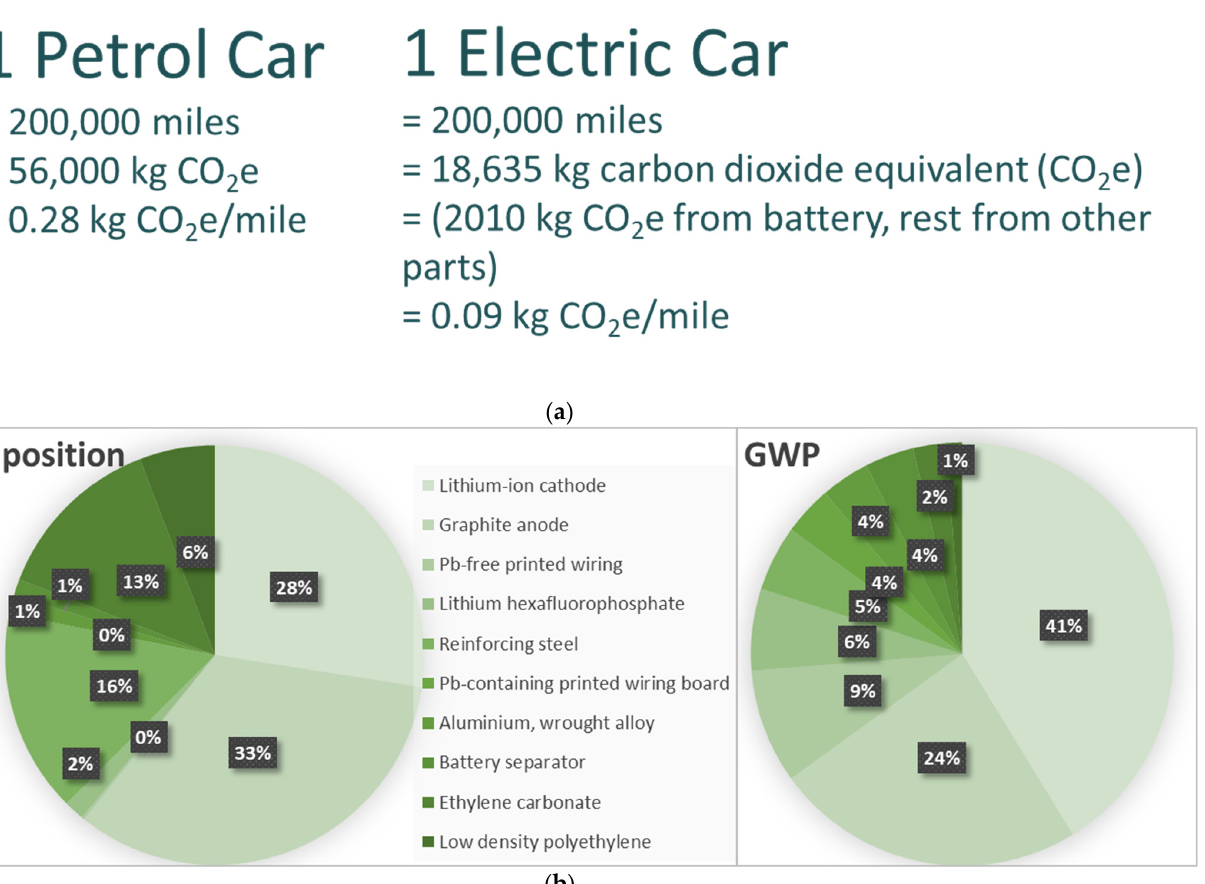
Figure 5. ( a ) GHG performances of average petrol and electric cars with electricity largely sourced from renewable resources. ( b ) Battery material (300 kg) composition and GHG (1618 kg CO 2 e). The total embedded greenhouse gas emissions of the battery materials are 1618 kg CO 2 e, 80% of LIB (2010 kg CO 2 e). The balance comes from waste treatment.